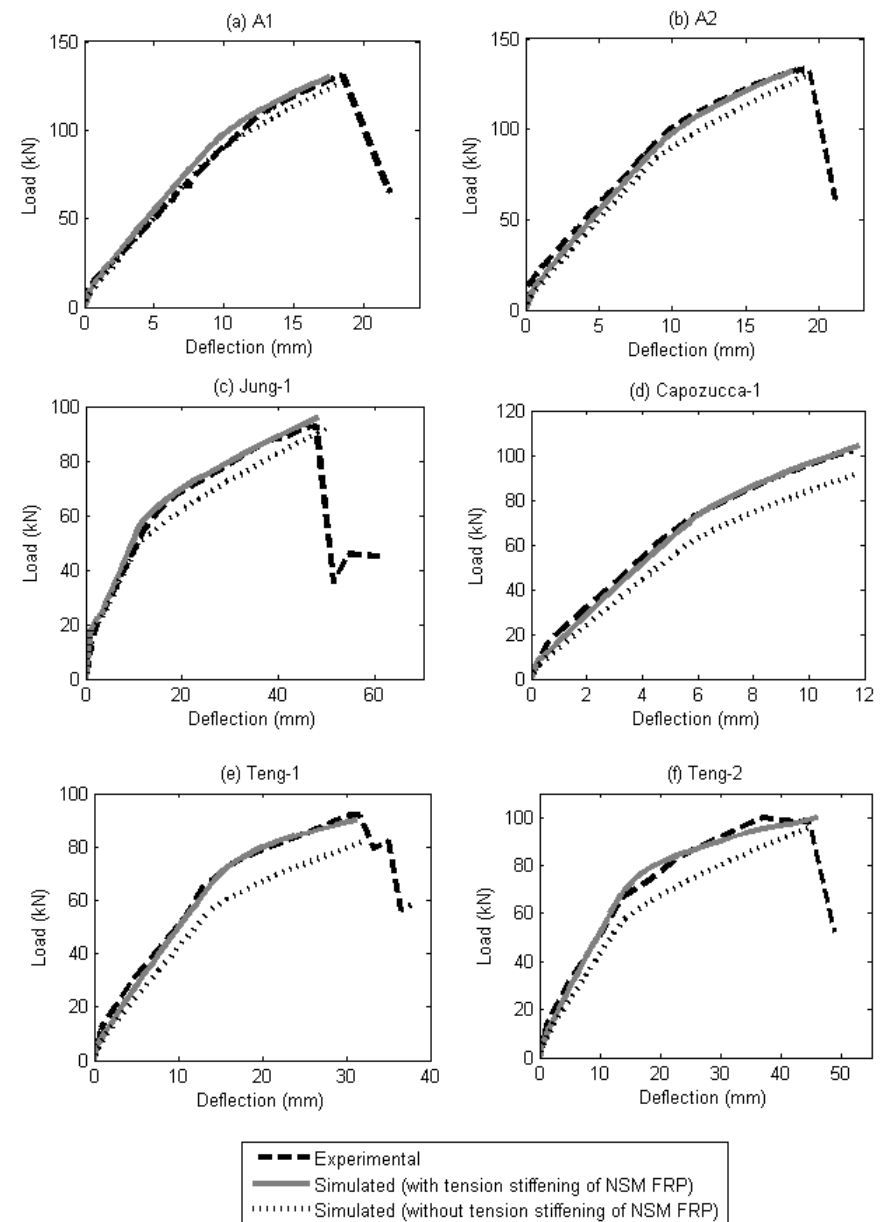
Figure 13. Effect of tension stiffening of NSM reinforcement. ( a ) A1; ( b ) A2; ( c ) Jung-1; ( d ) Capozucca-1; ( e ) Teng-1; ( f )